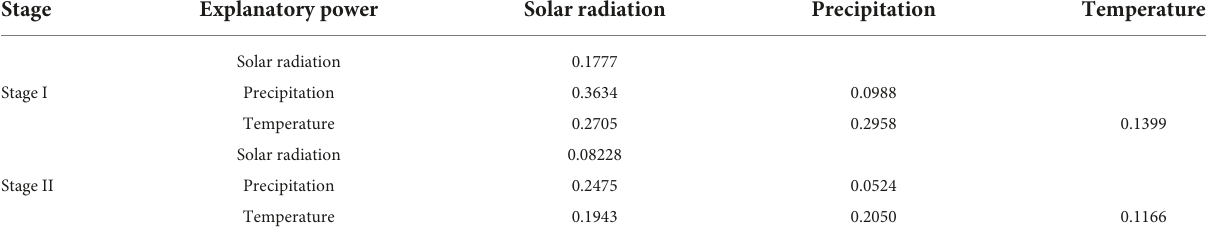
TABLE 3 The interaction between different climate